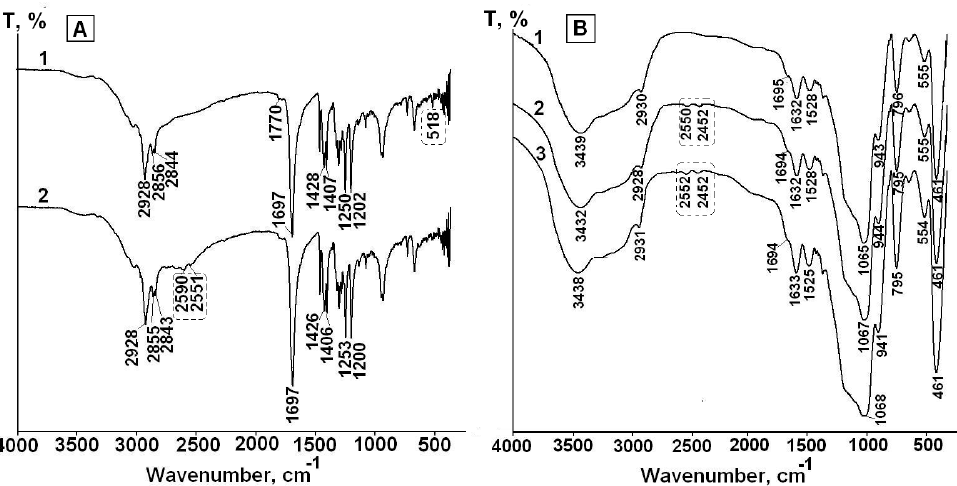
Figure 5. FTIR spectra of solid free LA before (1) and after UV irradiation for 4 h (2) ( A ) and LA in LA-APMS (pH 7) before (1) and after UV irradiation for 2 h (2) and 4 h (3) ( B ).